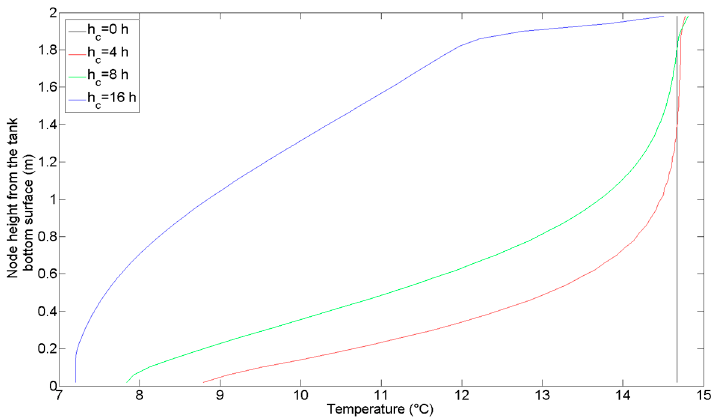
Figure 13. Temperature profiles in the cold water tank during the charging phase (h c = 0 h refers to the beginning of the phase).